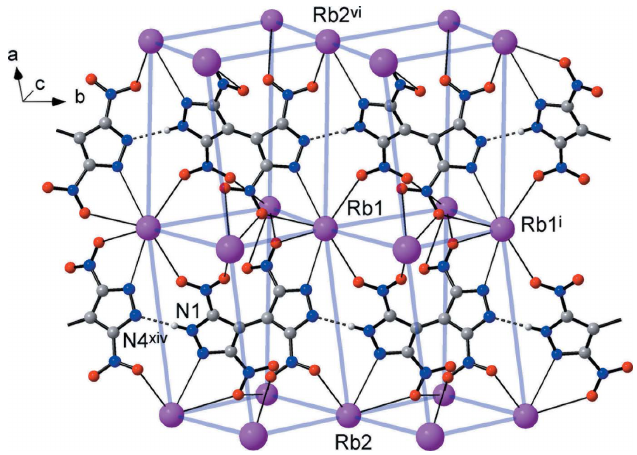
Figure 4 Fragment of the crystal structure of ( 1 ), showing the polar hydrogen- bonded anionic chains propagating along the b -axis direction, in the environment of the Rb cations. Blue lines indicate a pseudo-primitive cubic net arrangement of the cations, with every cell populated by a single anion ( c.f. the structure of CsCl). [Symmetry codes: (i) x , y + 1, z ; (vi) (cid:3) x + 1, y , (cid:3) z + 1 ; (xiv) x , y (cid:3) 1, z .] 2